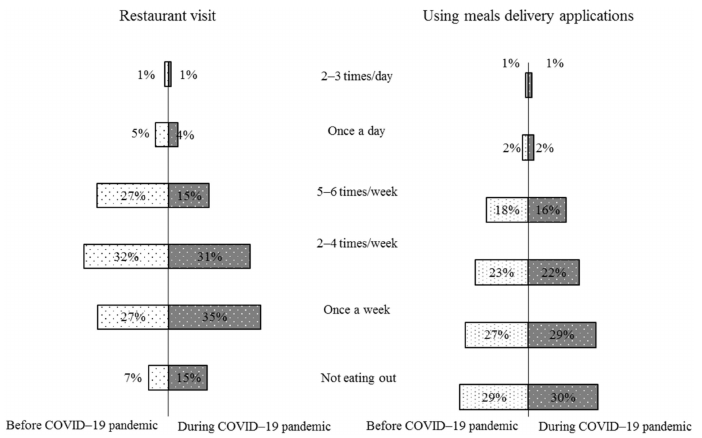
Figure 1. Frequency of restaurant visits and using food delivery applications before and after the COVID-19 pandemic (1657). Table 3. Interest in reading the energy labelling before and during the COVID-19 pandemic in restaurants and meal delivery applications ( n =